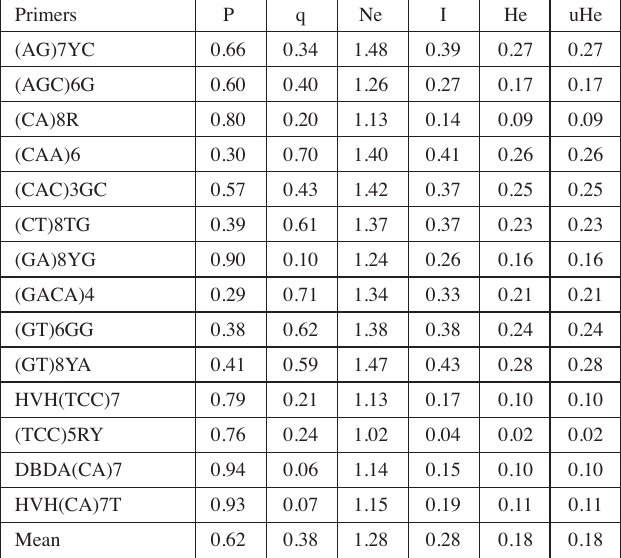
Tab. 3: ISSR primers studied, their estimated allele frequency (p & q), no of effective alleles (Ne), Shannon’s information index (I), expected (He) and unbiased expected heterozygosity